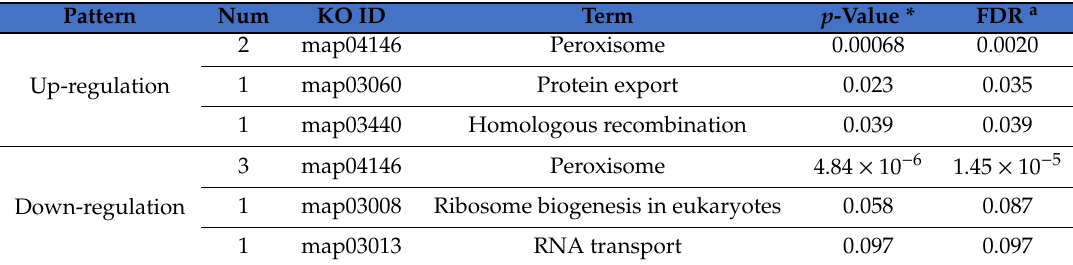
Figure 4. ROS related PPI networks induced by trypsin were constructed by cytoscape software. Rectangle nodes represented proteins encoded by downregulated genes, while round nodes